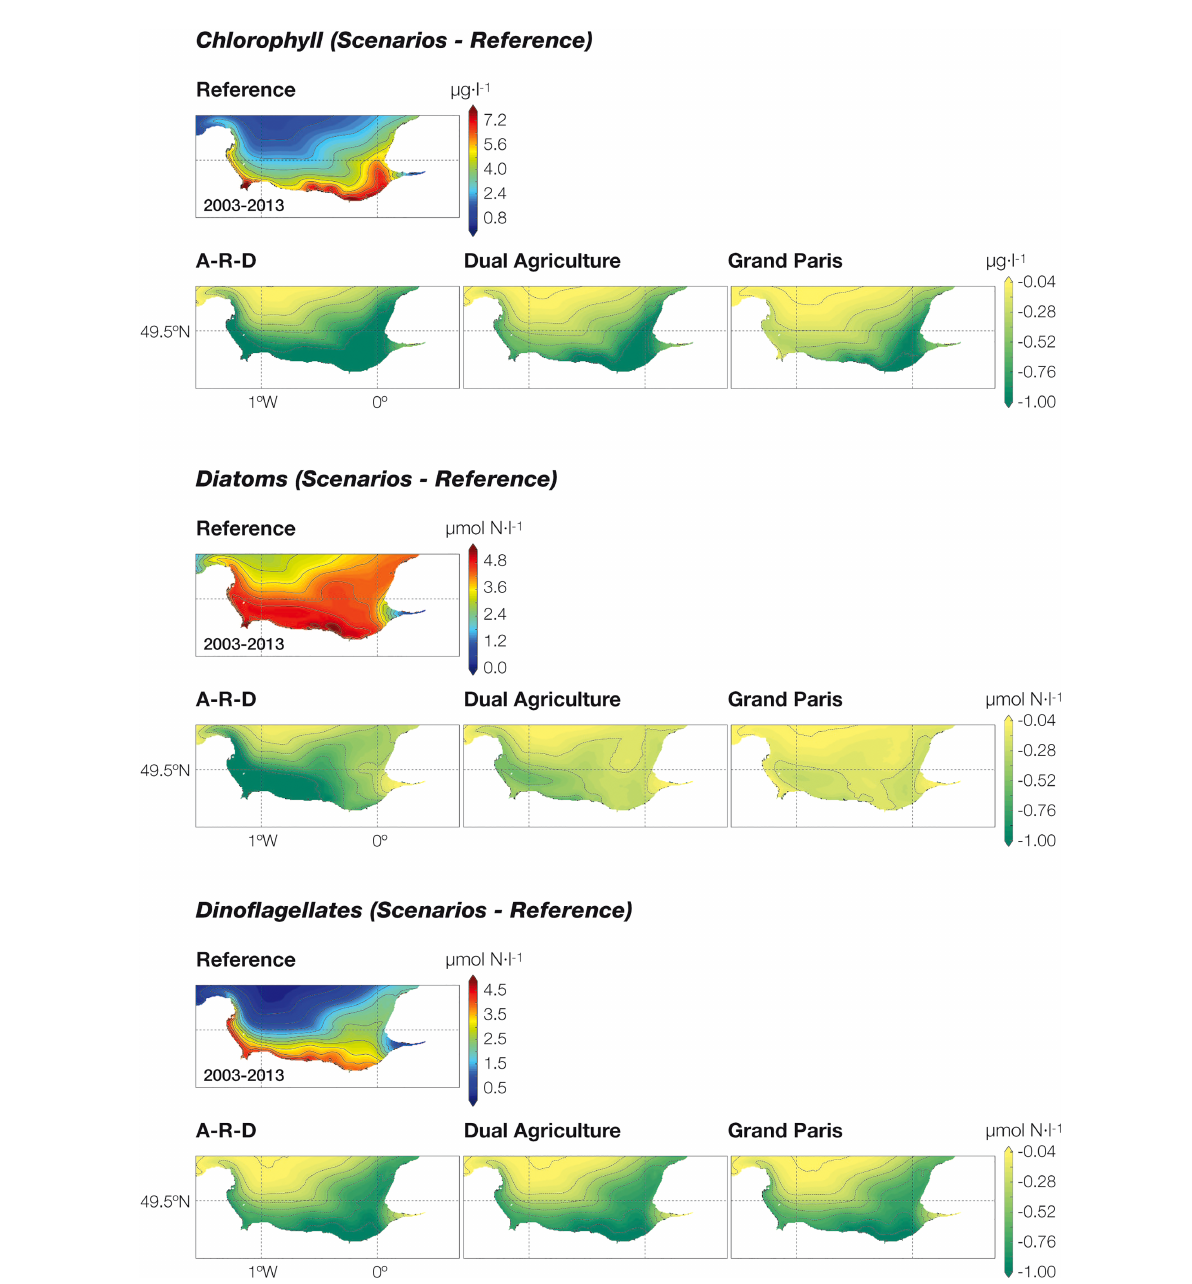
FIGURE 9 Concentration of chlorophyll, diatoms and dino fl agellates (expressed in µmol N·l -1 ) in the Seine Bight (average values for the 2003-2013 period). Note that, in order to highlight the divergences, we have plotted the difference between the reference situation and the outcome of each